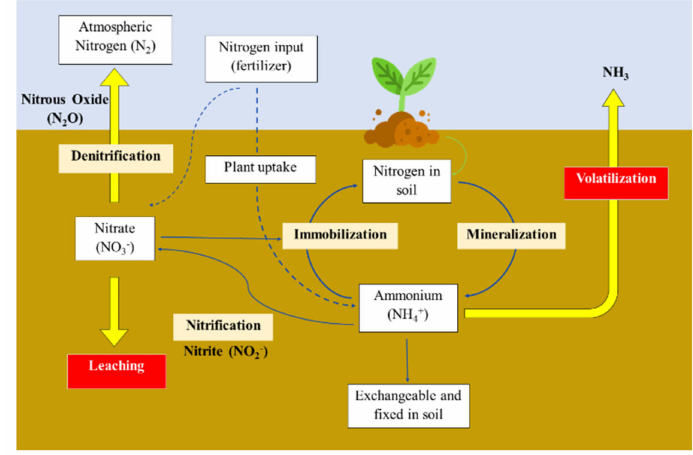
Figure 1. Nitrogen cycle in soil. Adapted from [23].